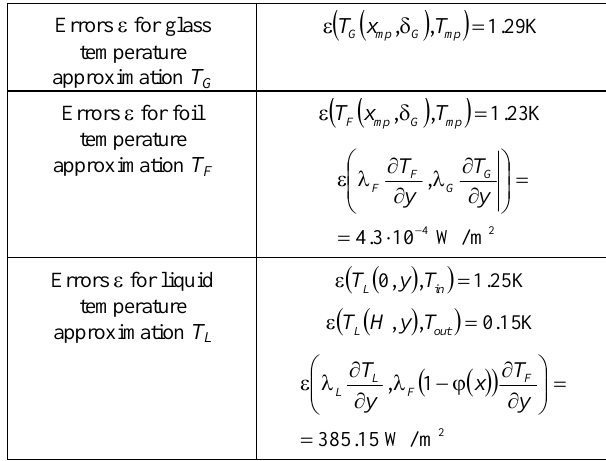
Table.1 Mean square errors e between temperature approximations and selected boundary conditions: additional data as in Fig. 2 for q V =1.97·10 5 kW/m 3 .